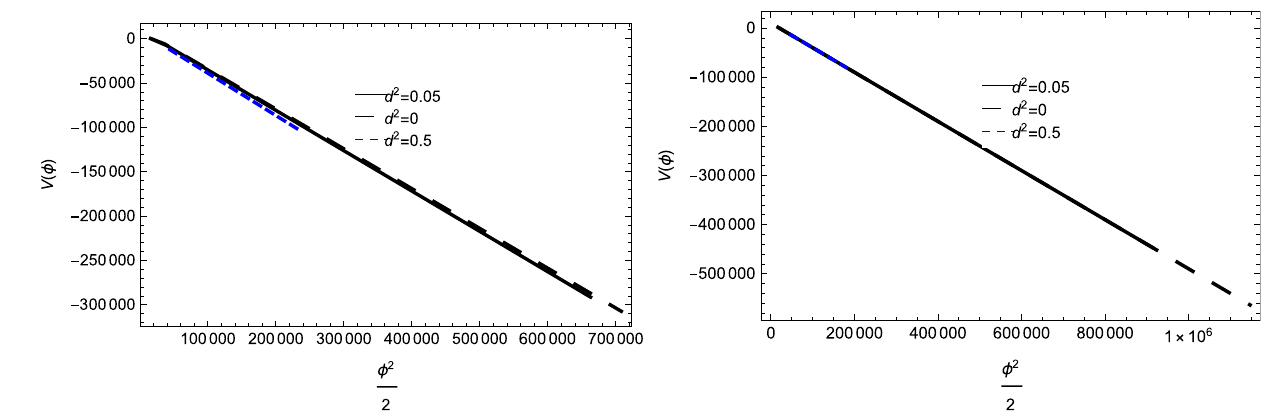
Fig. 7 Plot of φ( z ) verses V ( z ) for u = 1 and u = 2 . 002 for quintessence scalar field